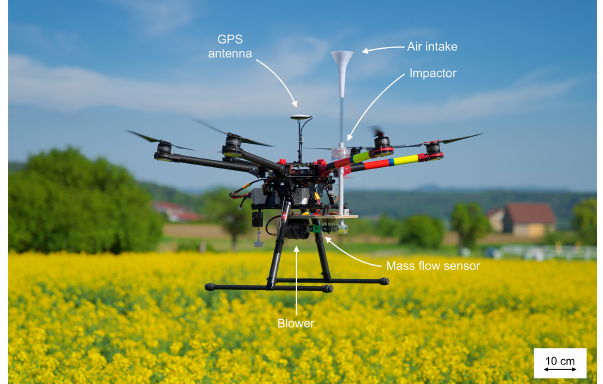
Figure 1. Multicopter UAV (DJI S900) in hovering flight with com- ponents of the particle collection system as indicated: air inlet, im- pactor, mass flow sensor, and blower. The inlet is arranged about 30cm above the propeller